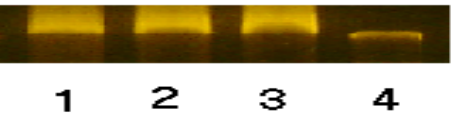
Figure 2 . Interaction between cobalt(II) p -nitrobenzoate and genomic DNA in presence of TAE buffer at pH 7.3 in air, and 24 h incubation. Lane 1-3: DNA + cobalt(II) p - nitrobenzoate with 0.14, 1.4 to 14 mM, respectively; lane 4: untreated genomic DNA in in TAE buffer at pH 7.3 in air, and incubation for 24